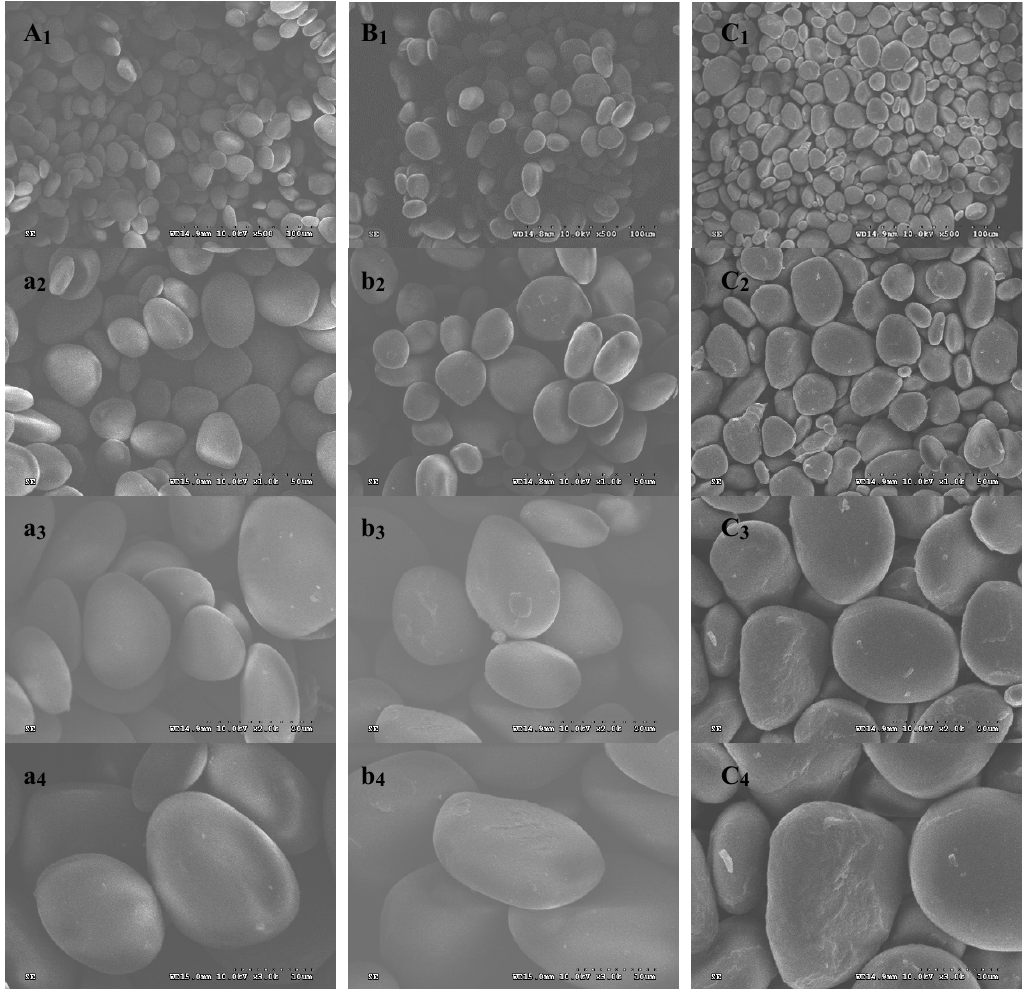
Figure 1. SEM micrographs of CYYS-1 ( A 1 – A 4 ), CYYS-2 ( B 1 – B 4 ), and CYYS-3 ( C 1 – C 4 ). CYYS-1, CYYS-2, and CYYS-3 represent NO. 1-, NO. 2-, and NO. 3-Chinese yam starches in Yunlong town, respectively.